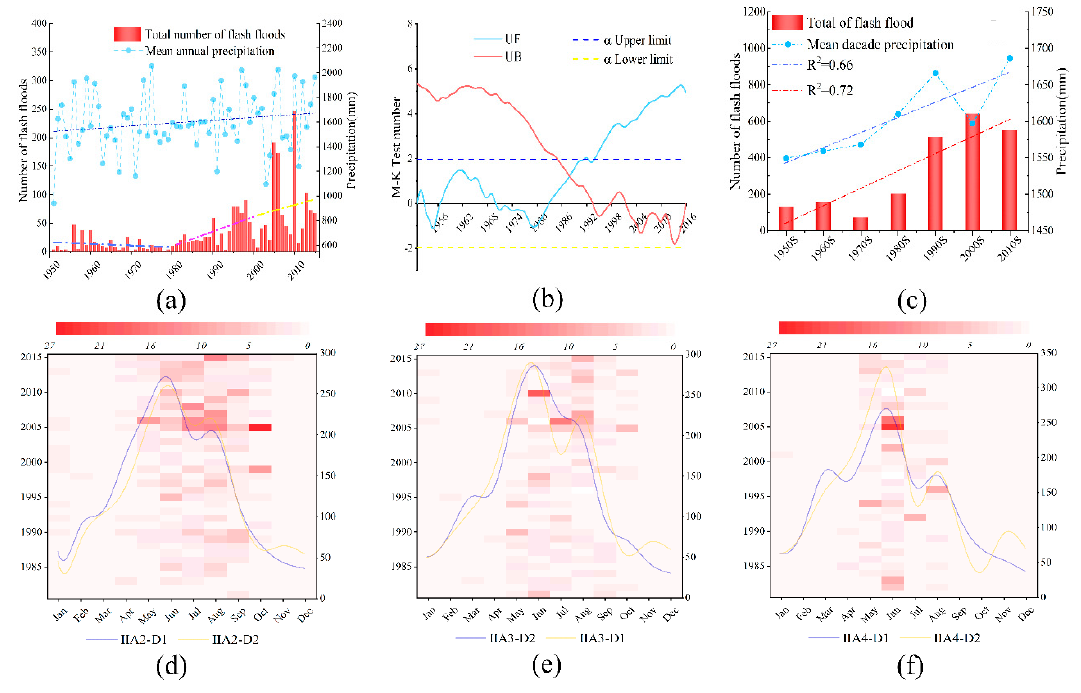
Figure 2. ( a ) The annual number of flash floods and the mean annual precipitation in Fujian Province from 1951 to 2015 and ( b ) flash flood mutation analysis using the Mann-Kendall test. ( c ) The interannual number of flash floods and the mean interannual precipitation in Fujian Province. ( d ), ( e ) and ( f ) are the monthly number of flash floods in IIA2, IIA3, and IIA4, respectively. The curves represent the mean monthly precipitation of two periods under different geomorphological regionalization.